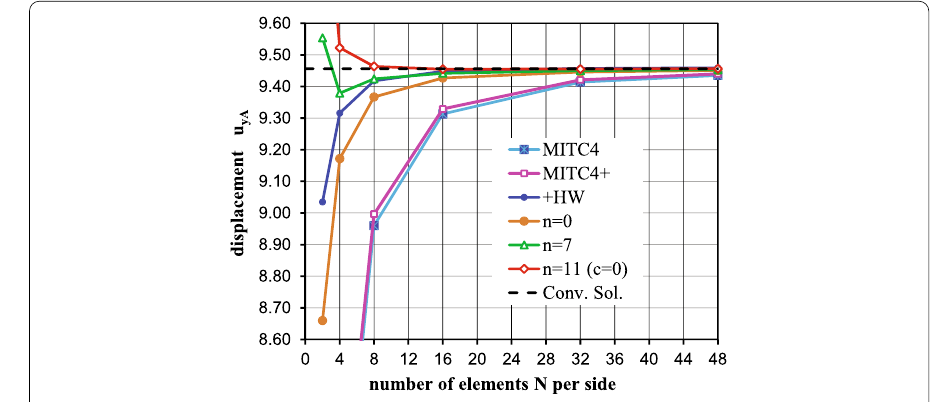
Fig. 30 Cook’s problem: convergence behavior u yA − N